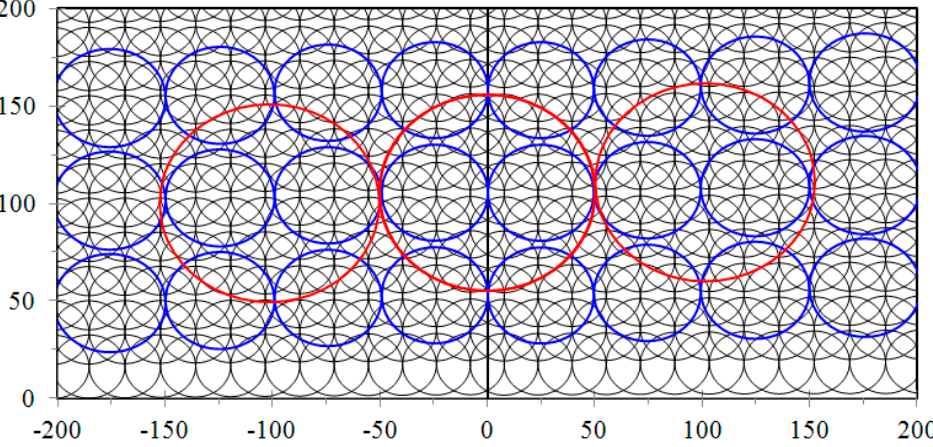
Figure 1. Advanced Technology Microwave Sounder (ATMS) Field of View Size for the beam width of 2.2°—black line, ATMS Resample to the Field of View Size for the beam width of 3.3°—blue line, Red line is for beam width of 5.2°. Axis unit is Kilometer [10].